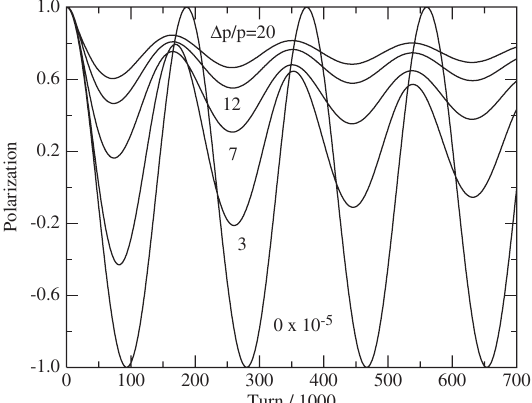
FIG. 11. A variety of time curves showing the vertical polar- ization oscillations induced by an rf solenoid operating on the 1 (cid:1) G(cid:1) resonance for a coasting beam with a Gaussian distri- bution of values of (cid:1) p=p . The curves from bottom to top represent responses calculated for a width of (cid:1) p=p ¼ 0 ; 3 ; 7 ; 12 , and 20 (cid:2) 10 (cid:1) 5 .